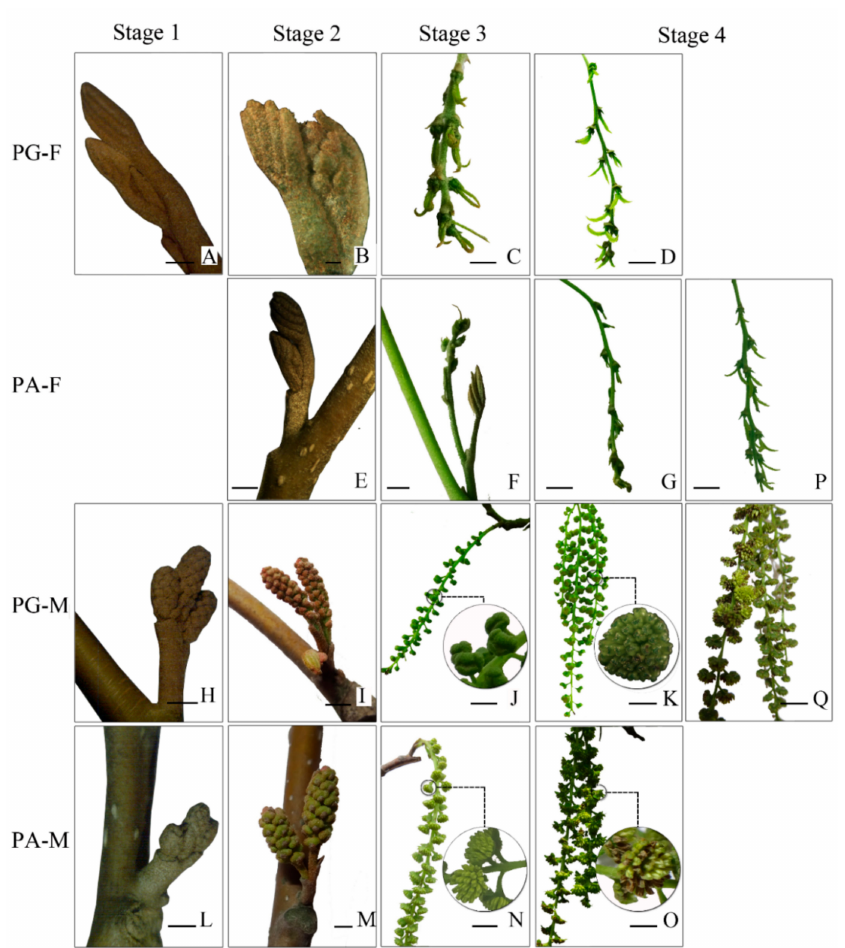
Figure 2. Morphological changes of flower development in C. paliurus. The bar is 0.2 cm ( B ); 0.5